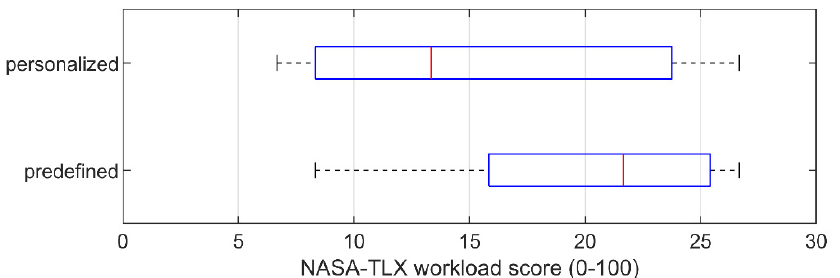
Figure 13. Results from the NASA TLX for the two interactions. The interaction with personalized gestures showed a lower workload compared with the predefined gestures.